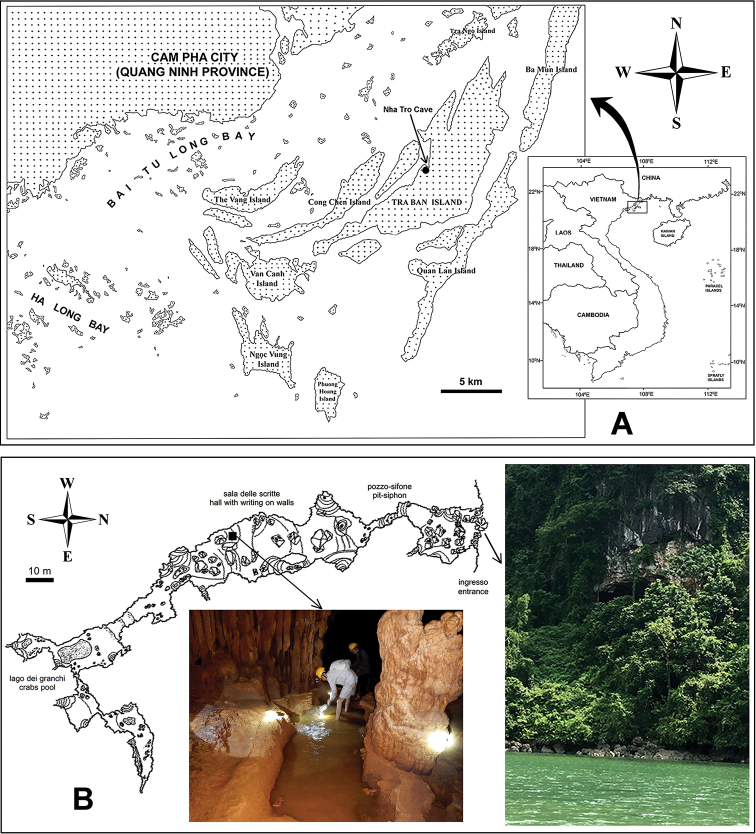
Sampling locations of Boholina
reducta sp. nov. A map of the Bai Tu Long Bay showing the location of Nha Tro Cave (arrow) B map of the Nha Tro Cave (cited from Donatis et al. 2010), designating the entrance from the sea and the type locality of the new species.